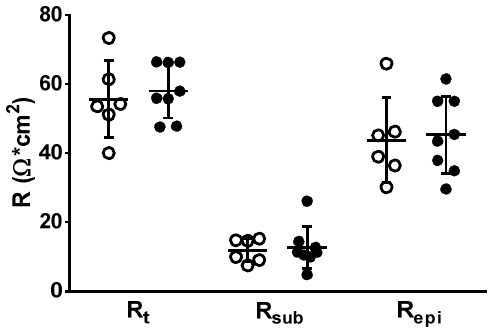
Figure 3. In impedance spectroscopy, epithelial (R epi ) and subepithelial resistance (R sub ) contribu- tions to the overall electrical resistance (R t ) in human colon biopsies. R sub reflects differences in subepithelial tissue layers, e.g., as a result of inflammation. In case of an inflamed subepithelium, the increased R sub may mask the overall resistance defect (R t ). White circle = control values, black circles = PI-IBS values. No differences were found between groups using Student’s t -test.